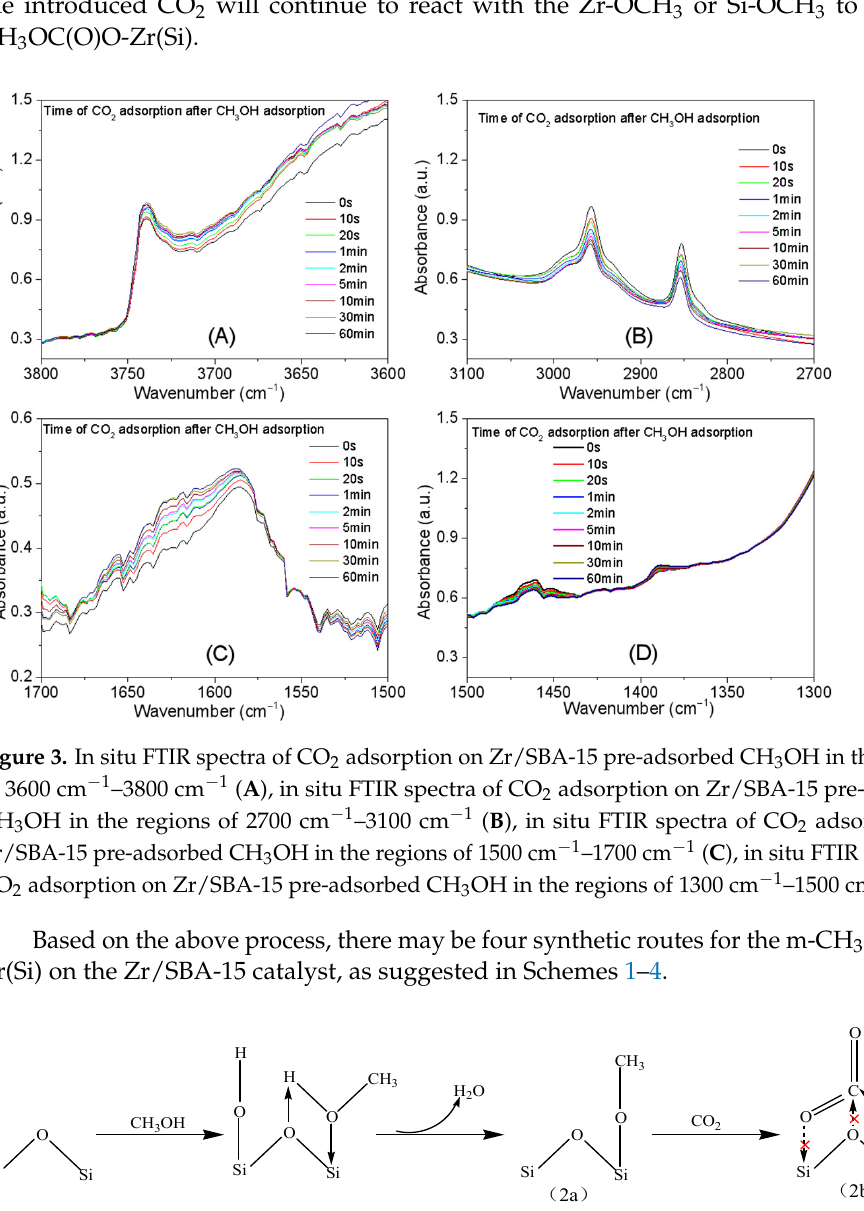
（ 2a ） （ 2b ） Scheme 2. Synthetic routes for the m-CH 3 OC(O)O-Zr(Si) on the Zr/SBA-15 catalyst.